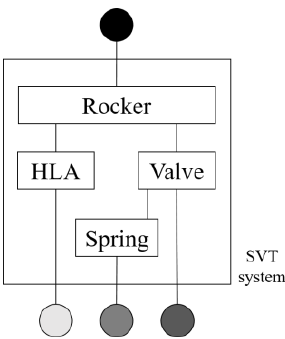
Figure 14. The topology of the SVT system.